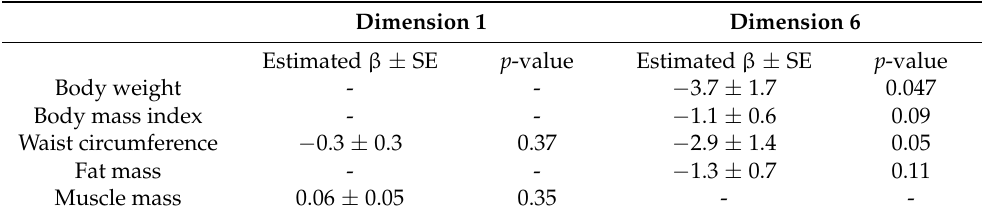
Data show estimated beta coefficient ± standard error (SE) and its associated p -value. The models were adjusted by maternal age, gestational age, ethnicity, study level, employment status, and breastfeeding supplementation